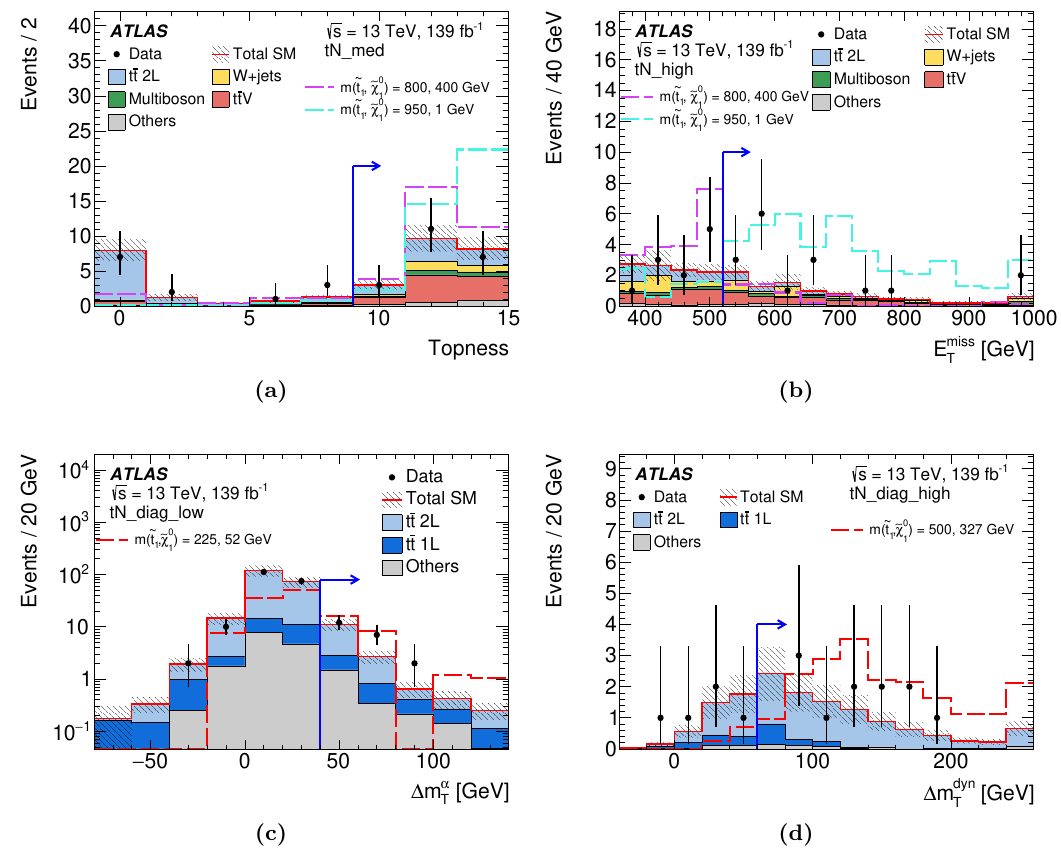
Figure 11. Kinematic distributions in the (a) tN_med , (b) tN_high , (c) tN_diag_low and (d) tN_diag_high SRs. The full event selection in the corresponding signal region is applied, except for the requirement (indicated by an arrow) that is imposed on the variable being plotted. The distributions shown are post-fit, i.e. each background is scaled by a normalisation factor obtained from a background-only likelihood fit to the CRs (see table 14). In addition to the background prediction, a signal model is shown on each plot. The hatched area around the total SM prediction includes statistical and experimental uncertainties. The last (first) bin contains overflows